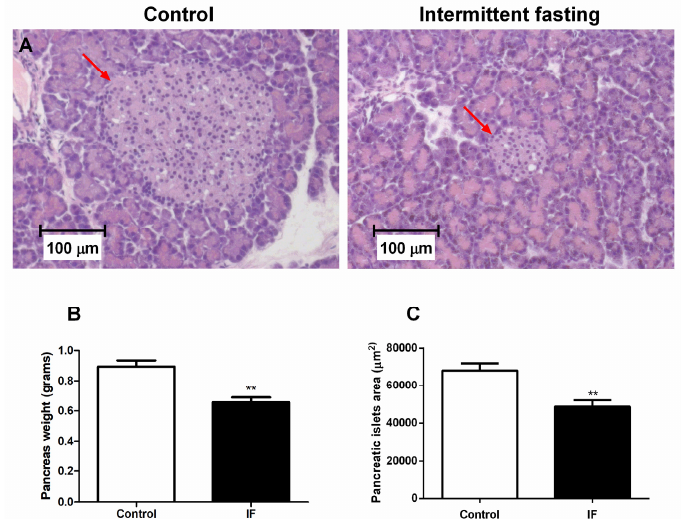
Figure 11. ( A ) Pancreatic islet of the longitudinal cut of pancreas caudal portion, ( B ) pancreas weight related to body weight, and ( C ) pancreatic islets area from Wistar rats submitted to IF for 12 weeks (Hematoxylin-eosin stained tissue (H&E) and 100x magnification). The results were presented as the mean ± standard error of the mean (SEM) with 5 different animals for each group. ** p <0.005 compared to the control, as indicated by Student’s t